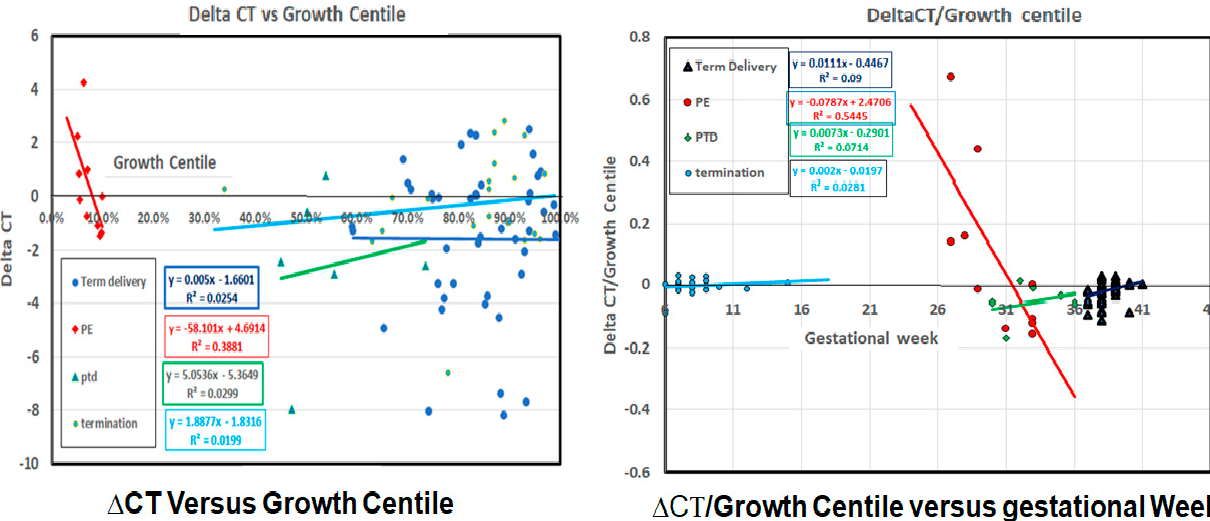
Figure 2. CD24 mRNA expression and fetal growth characteristics. Left - ∆ CT versus growth centile. The mRNA expression assessed via ∆ CT is presented for the various clinical outcome groups, indicating high correlation only for the case of the preterm preeclampsia (PE) group. Right - ∆ CT/growth centile versus gestational week. The ∆ CT/growth centile shows a correlation to gestational week at delivery only for the preterm PE cases. PE-preeclampsia, PTD-preterm delivery. Linear regression for each group is shown with regression curve and coefficient listed in the figure.